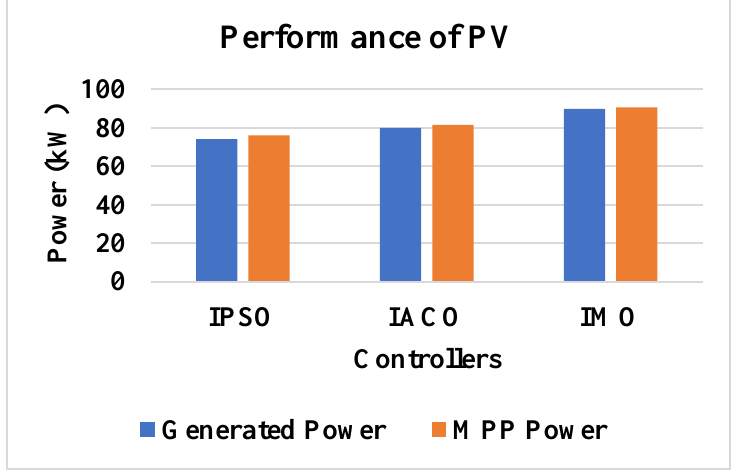
Figure 7. PV power for IPSO method.